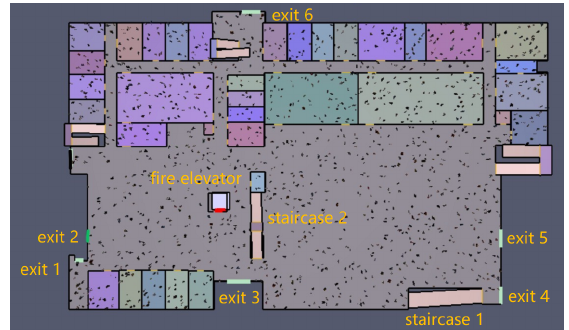
Fig. 1 Floor plan of canteen.